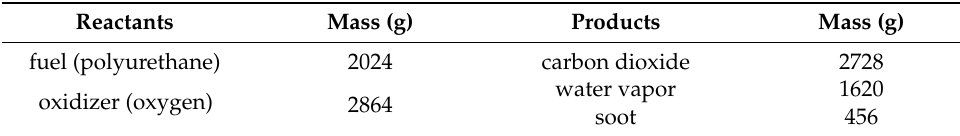
Table 3. Mass balance of adopted combustion reaction. Reactants Mass (g)